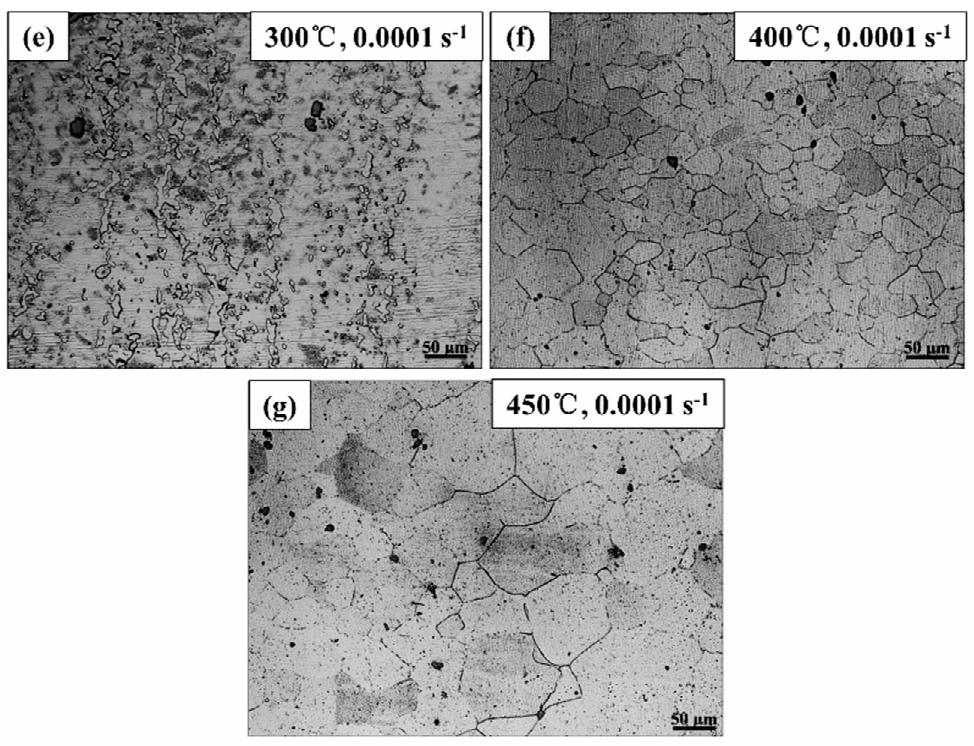
Figure 3. Microstructures of nanohybrid/AZ80 composite after high temperature compression test: ( a ) 350, 0.1; ( b ) 350, 0.01; ( c ) 350, 0.001; ( d ) 350, 0.0001; ( e ) 300, 0.0001; ( f ) 400, 0.0001; and ( g ) 450 °C, 0.0001 s − 1 .